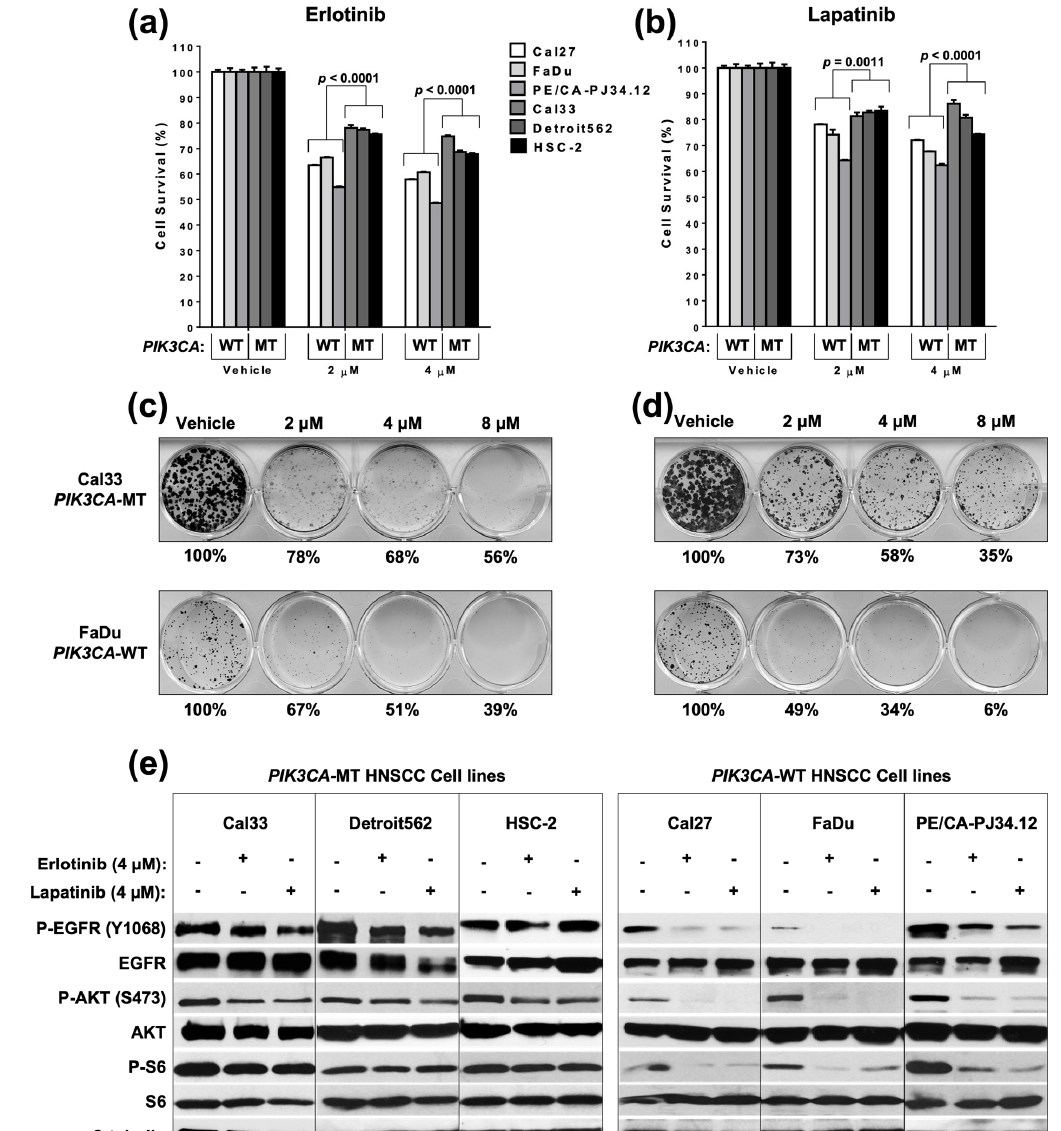
Figure 1. HNSCC cells with PIK3CA mutation are resistant to EGFR TKIs. HNSCC cell lines with WT PIK3CA (Cal27, FaDu, and PE/CA-PJ34.12) or PIK3CA mutation (p.H1047R; Cal33, Detroit562, and HSC-2) were treated with the indicated concentration of ( a ) erlotinib, or ( b ) lapatinib, for 48 h followed by MTT assay. p values were calculated using two-tailed T -tests with Welch’s correction, as appropriate. Bars represent mean + SEM. Cells were alternatively treated with the indicated concentrations of ( c ) erlotinib or ( d ) lapatinib for 10 days, followed by crystal violet staining. Percentages indicate the number of colonies relative to vehicle control counted using ImageJ software. ( e ) HNSCC cells were treated as indicated for 24 h followed by collection of whole cell lysate and immunoblot analysis.